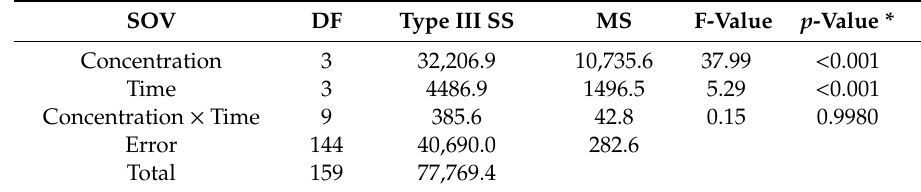
Table 1. Univariate analysis of variance table for the effect of partially purified protein derived from B. bassiana (ARSEF 2860) on the survival percentage of B. tabaci (cf. Figure 2). SOV